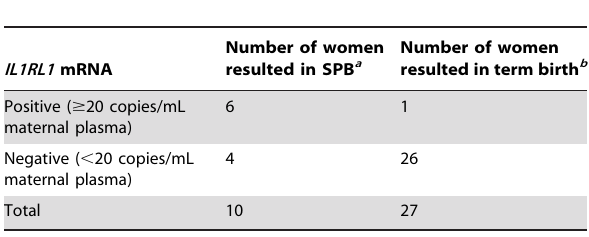
Table 7. Detection of IL1RL1 mRNA in gestational age- matched maternal plasma